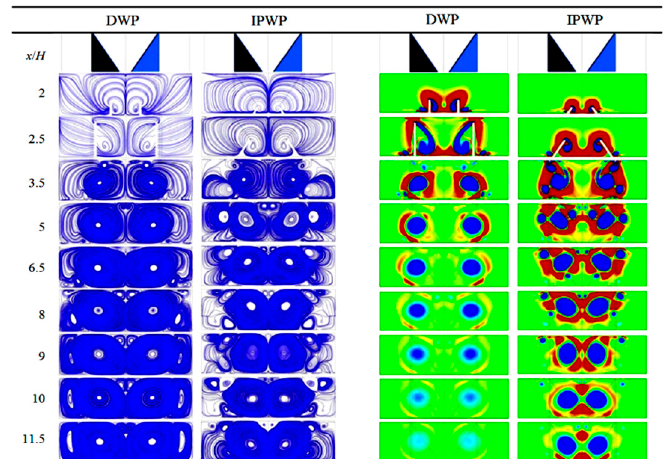
Figure 7. Velocity streamlines and contours for the delta winglet pair (DWP) and inclined projected winglet pair (IPWP) configurations at different section planes [106].